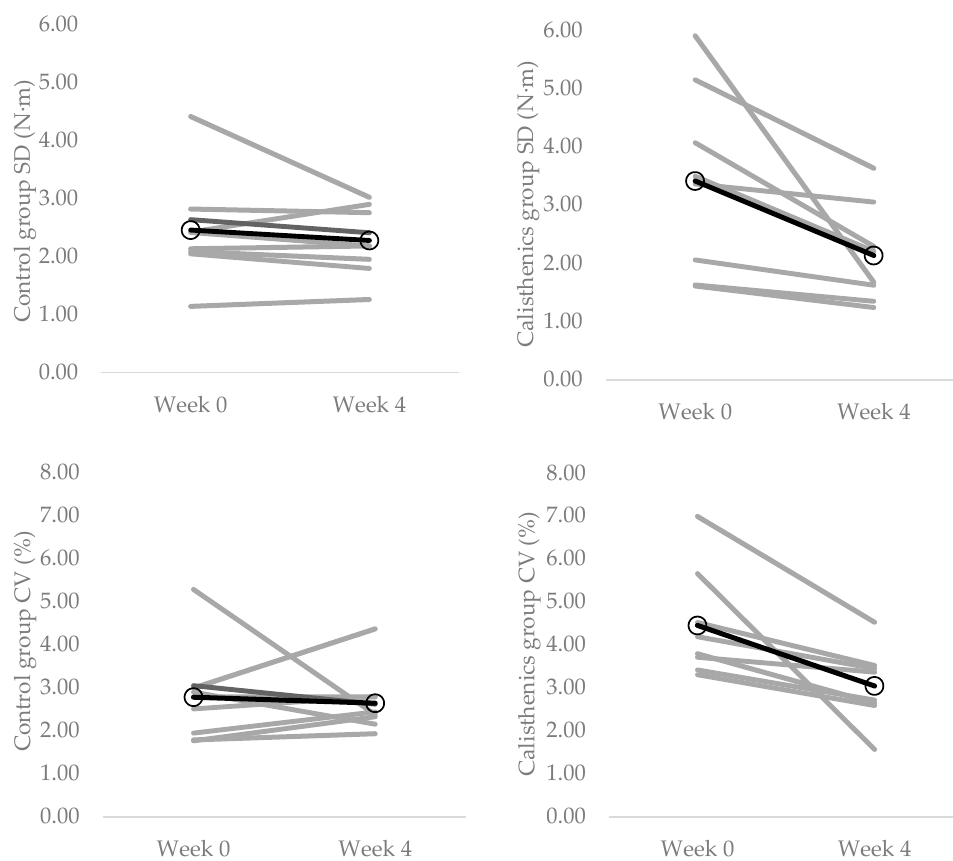
Figure 2. Individual changes (grey lines) in knee extensor force control during contractions at 40% MVC from baseline (week 0) to the end of the intervention (week 4). Top left panel = control group SD; Top right panel = calisthenics intervention group SD; Bottom left panel = control group CV; Bottom right panel = calisthenics intervention group CV. Dark lines represent group means.